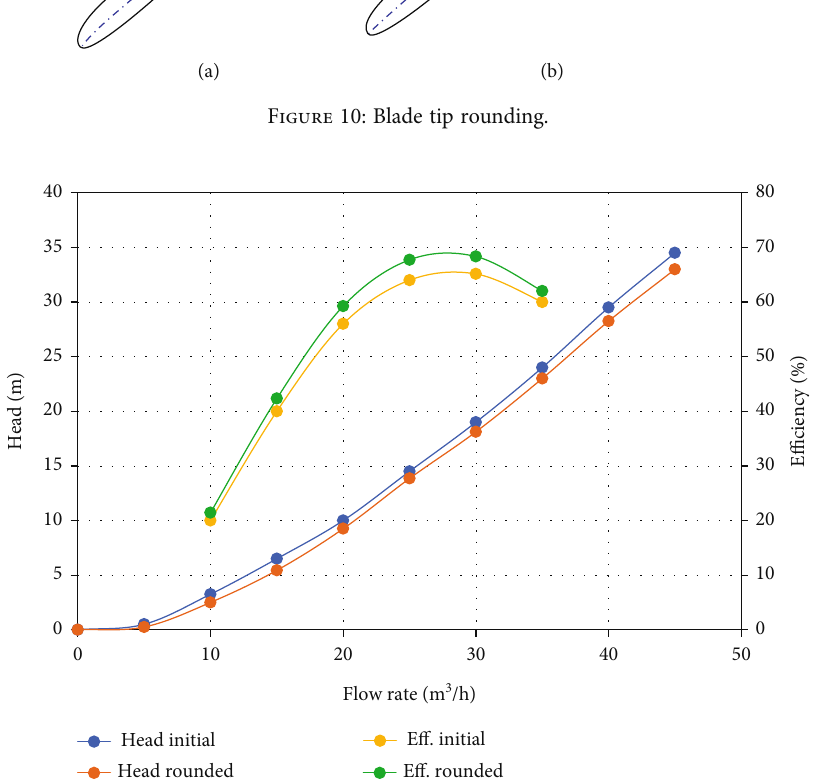
Figure 11: PAT performance and the in fl uence of blade rounding.